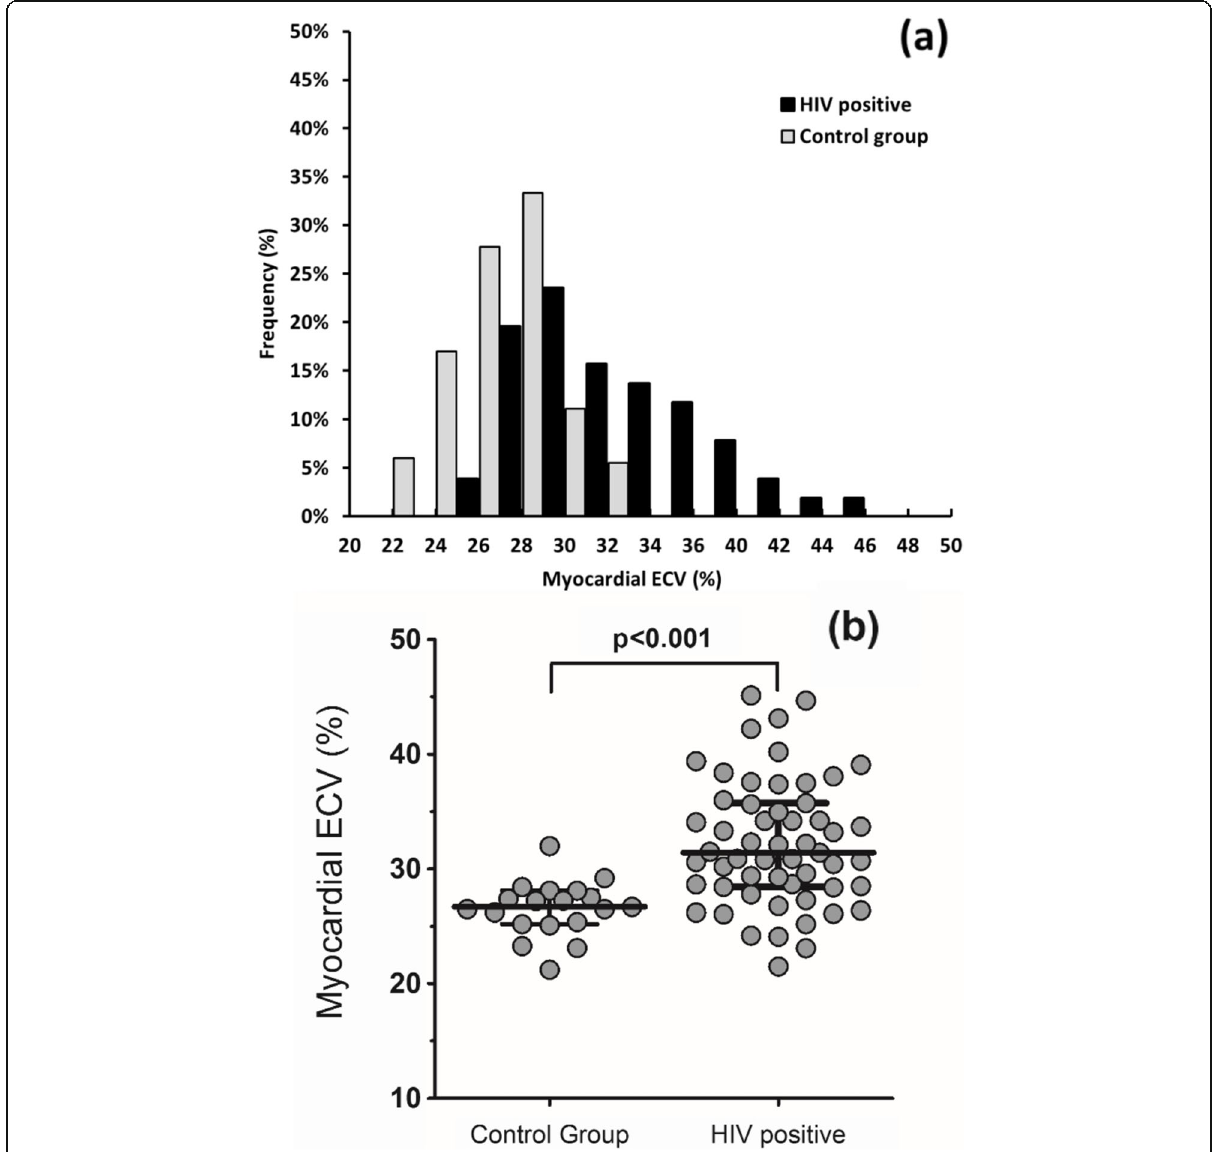
Fig. 1 a Frequency histograms of ECV fraction. b Boxplot comparing ECV in controls and HIV+ patients: median, interquartile range (25%-75%) and p -value of the Mann-Whitney test for significance are also